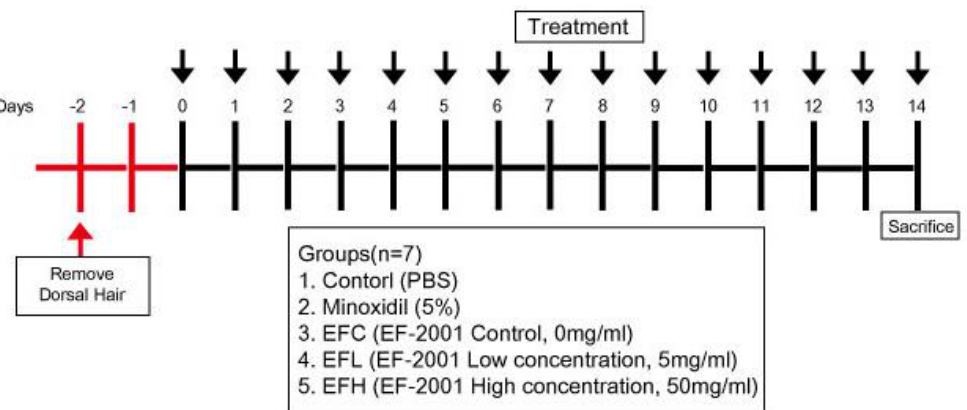
Figure 9. Schematic diagram of experimental protocol in C57BL/6